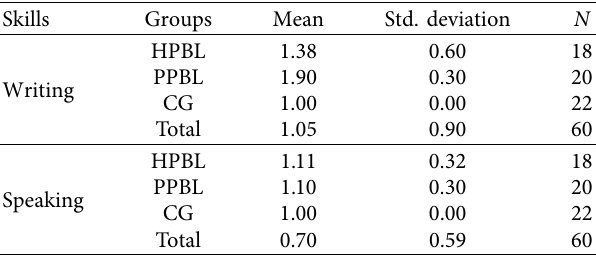
Table 5: Descriptive statistics for the learners’ writing and speaking gain